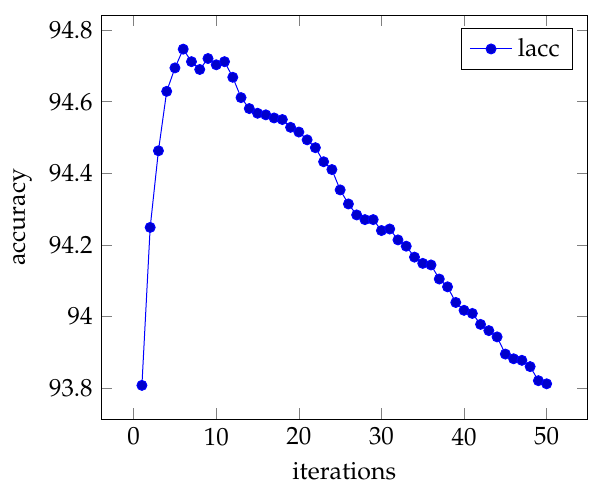
Figure 3. Accuracy of dependency parsing on the validation set.